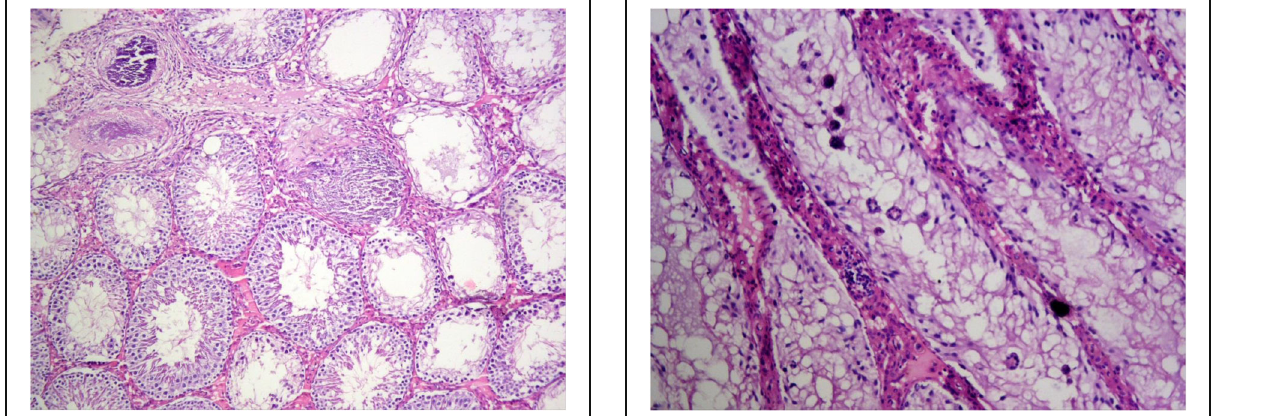
Fig. 5 Testicular section from the tramadol group showing vacuolar degeneration with intratubular apoptotic bodies and abnormal giant